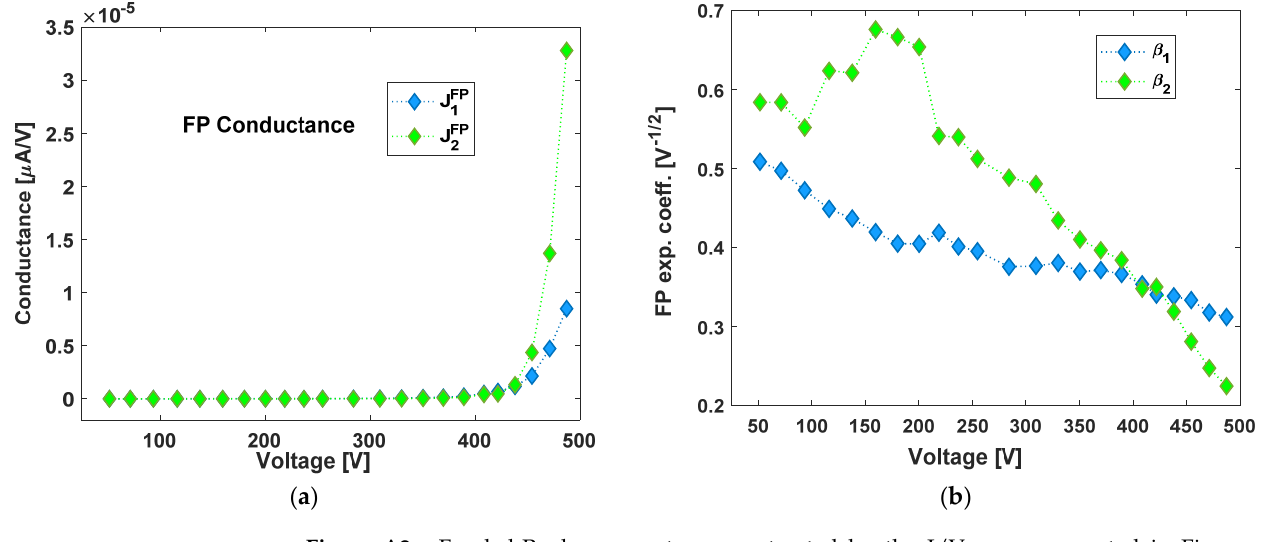
Figure A2. Frenkel-Poole parameters as extracted by the I/V curves reported in Figure A1. ( a ) Extraction of Conductance for V < 230 V (blue curve, number 1 subscript in the legend) and for V < 500 V (green curve, number 2 subscript in the legend); ( b ) Extraction of Exponential Coefficient for V < 230 V (blue curve, number 1 subscript in the legend) and for V < 500 V (green curve, number 2 subscript in the legend).